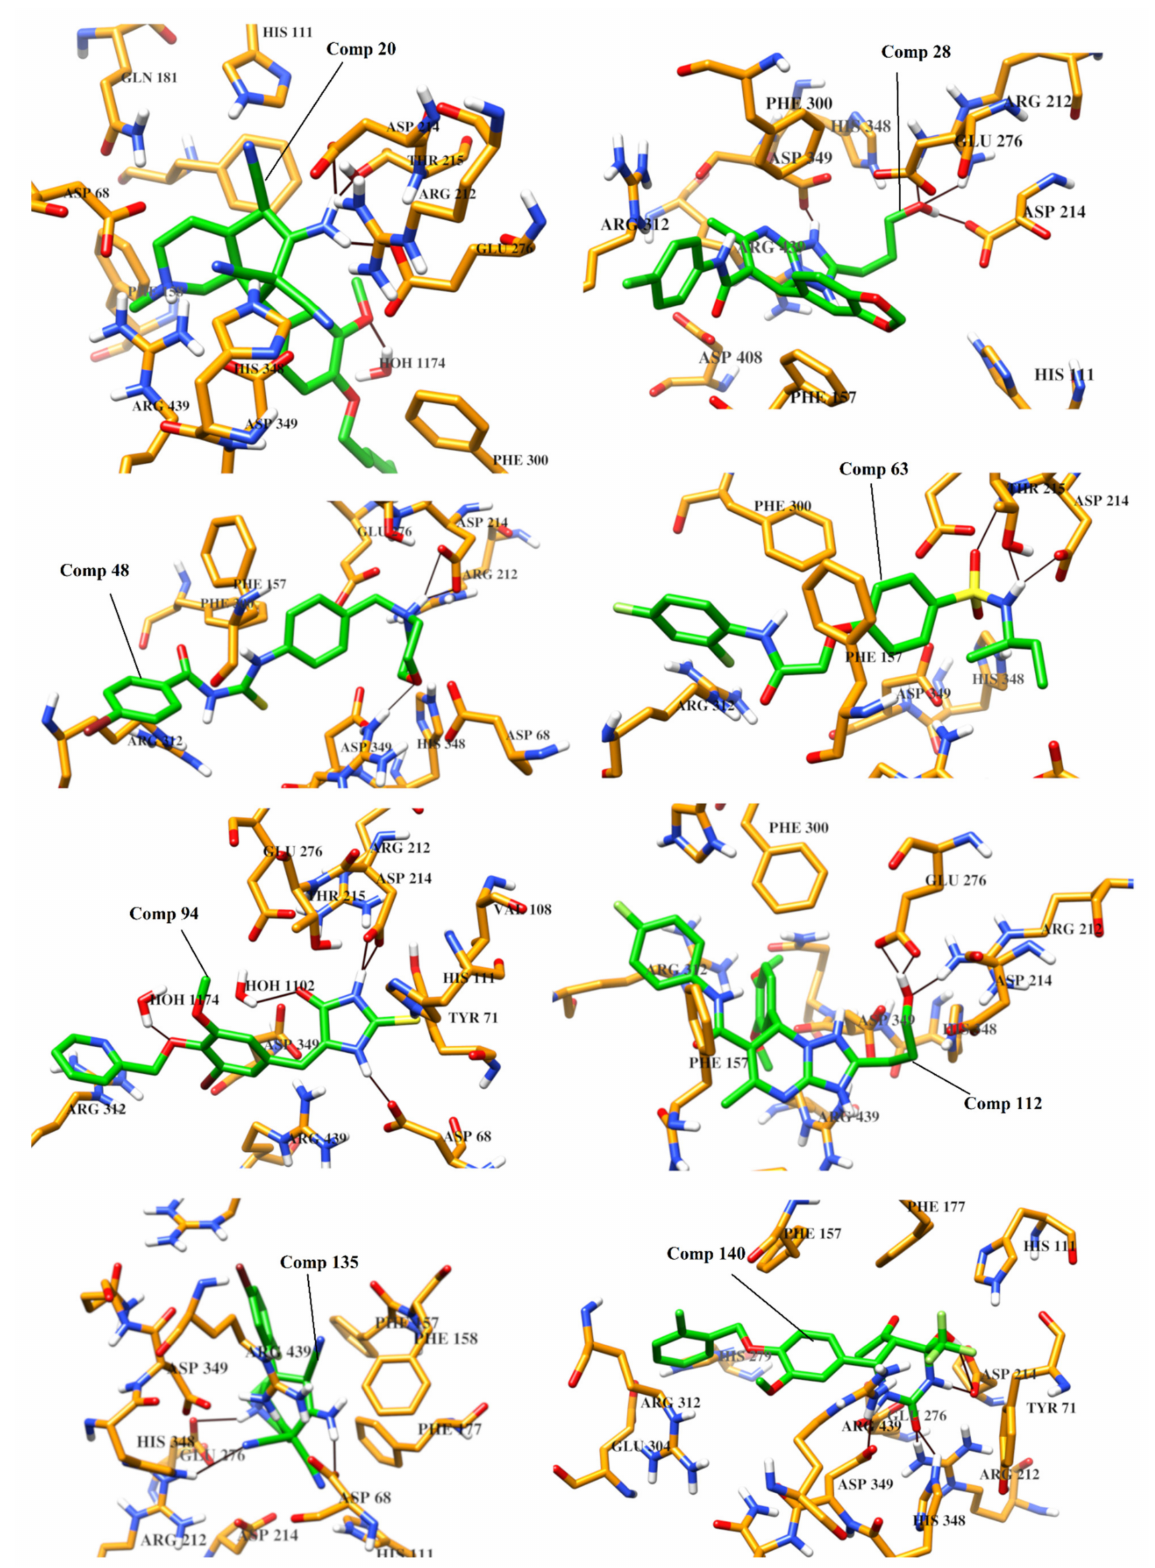
Figure 5. The binding modes of compounds 20, 28, 48, 63, 94, 112, 135 and 140 are depicted in the active site of α -glucosidase. Ligands are shown in green stick model, H-bonds are displayed in black lines, the active site residues are presented in orange stick